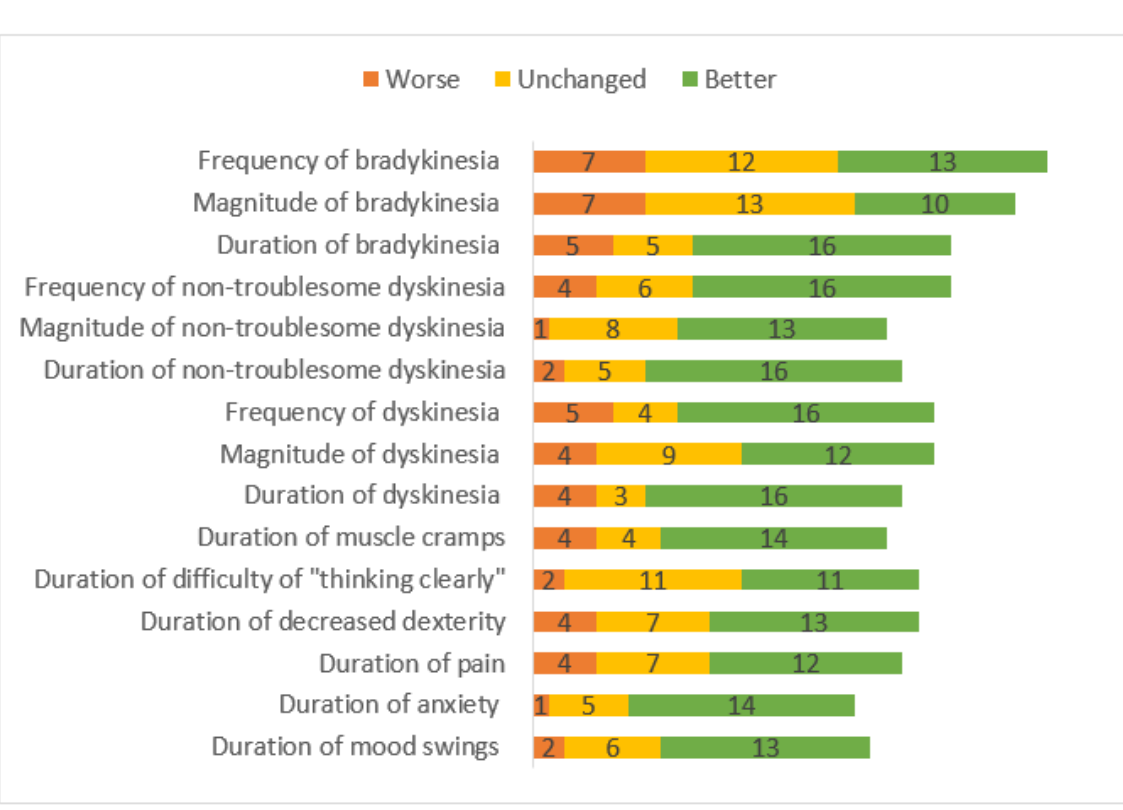
Figure 1. The patient-reported experienced change in bradykinesia and dyskinesia, as well as mood swings, pain, cognitive symptoms, and muscle cramps during LC-5 treatment. The response alternatives for “much worse” and “worse” are combined as “worse”, as well as “better” and “much better”, combined as “better”.